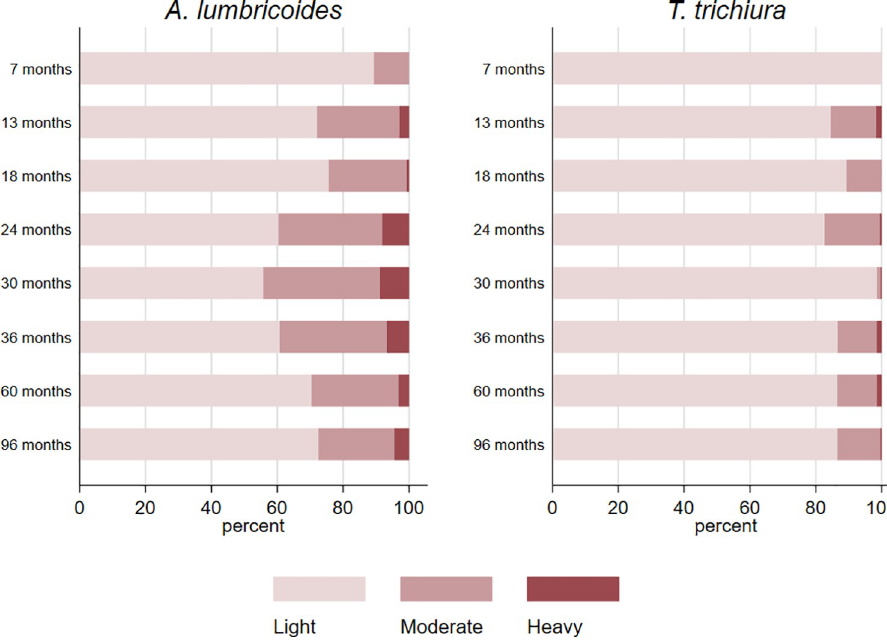
Fig 3. Relative frequencies of parasite burdens (light, moderate, and heavy) with A . lumbricoides and T . trichiura observed among infected children during the first 8 years of life. Infection intensity categories were as recommended by WHO: A. lumbricoides, light (1–4,999), moderate (5,000–49,999), heavy ( > = 50,000); T . trichiura , light (1–999), moderate (1,000–9,999), heavy ( > =